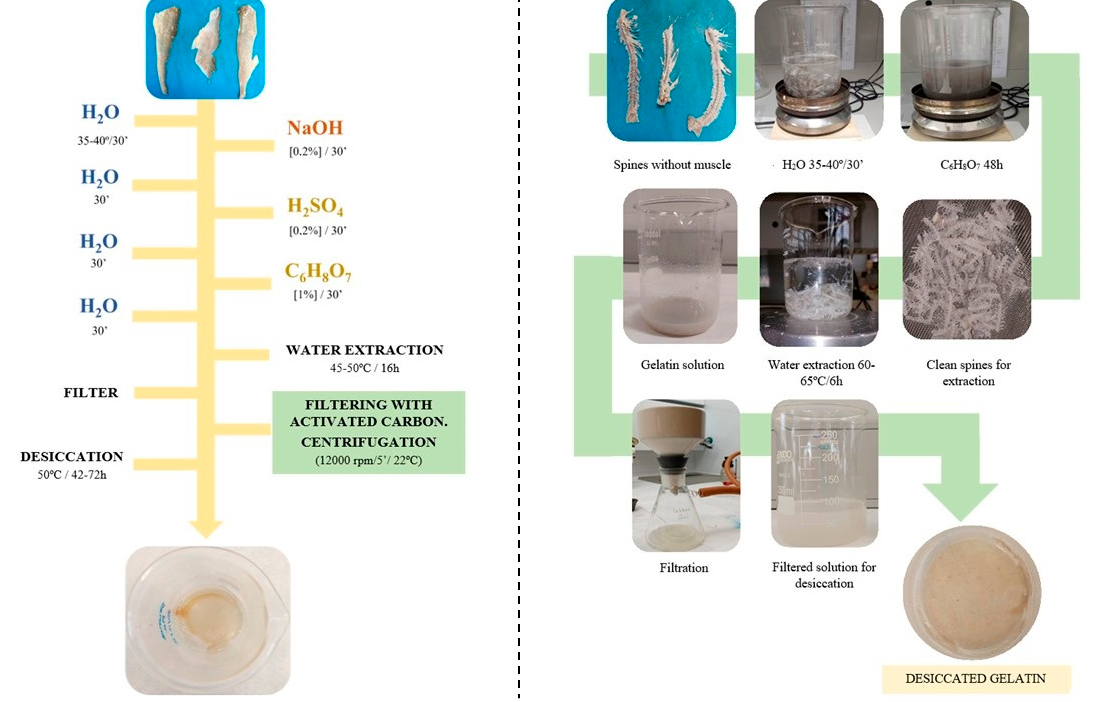
Figure 2. Overall process for preparation of fish gelatin from tench byproducts.